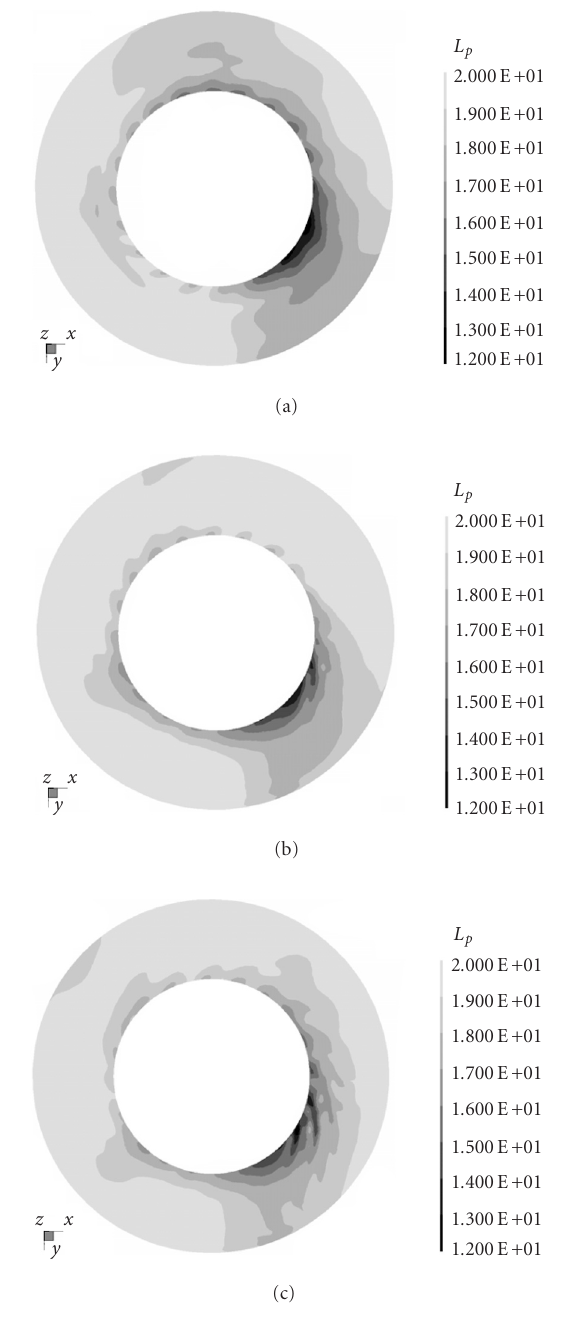
Figure 16: Static pressure on the vaned di ff user center plane at de- sign conditions: (a) starting position, (b) 1 / 3 revolution, and (c) 2 / 3 revolution.